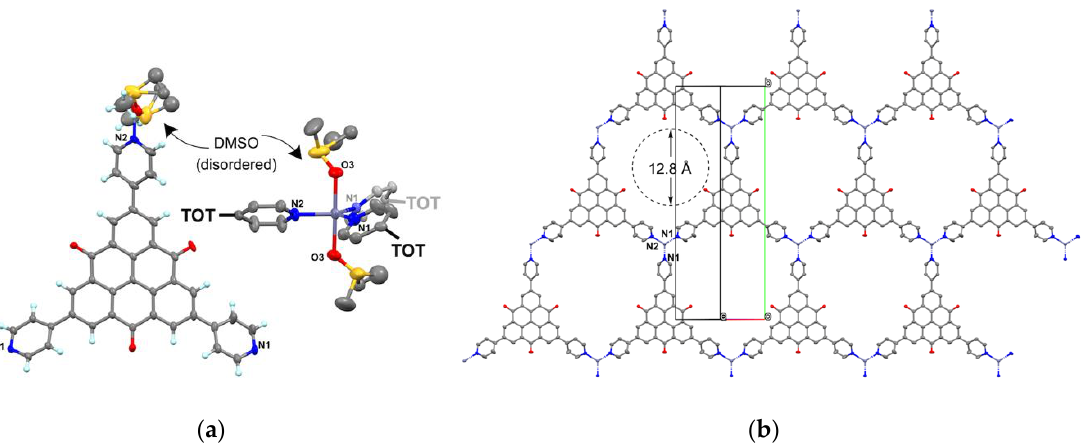
Figure 4. Crystal structure of 5 . ( a ) Molecular structure of TOT 4 − and the coordination sphere around the zinc(II) ion; ( b ) 2D coordination network with a cavity of ca. 12.8 Å in diameter. In ( b ), hydrogen atoms, DMSO and disordered NO 3 − , and solvent molecules are omitted for clarity. Color code: carbon (gray), nitrogen (blue), oxygen (red), sulfur (yellow), zinc (blue gray).